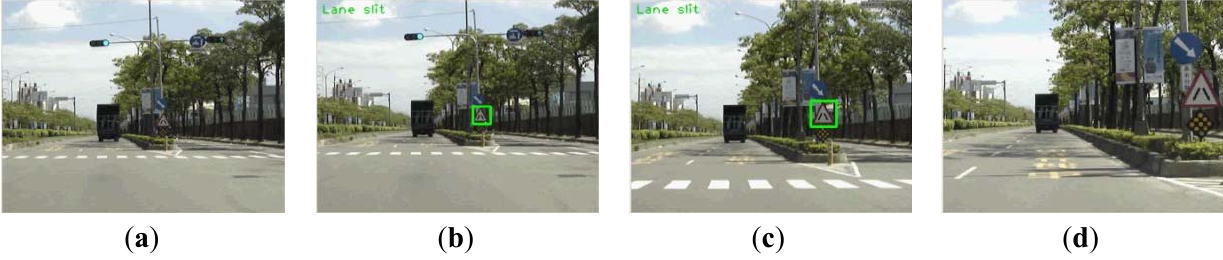
Figure 14 . Road sign appearing in a sequence of frames: ( a ) too small to be detected; ( b ) correctly recognized; ( c ) correctly recognized; ( d ) out of the detecting area and thus no